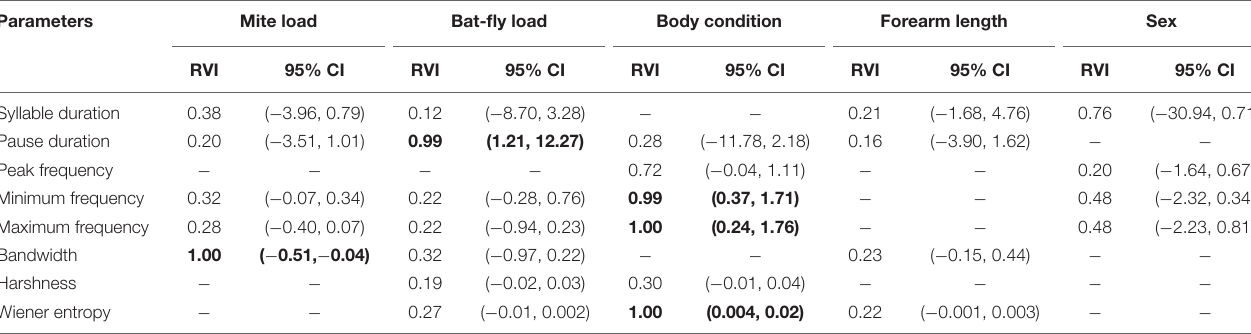
TABLE 1 | Model-averaged parameter estimates of strongly supported linear models ( (cid:49) AICc ≤ 2) explaining the inter-individual variation of distress calls in Rhinolophus sinicus . Parameters Mite load Bat-fly load Body condition Forearm length Sex